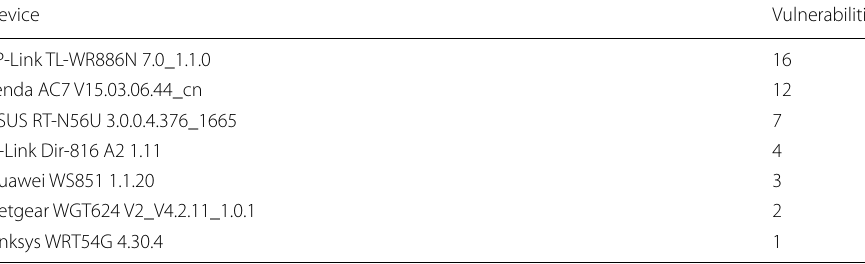
Table 2 Evaluation